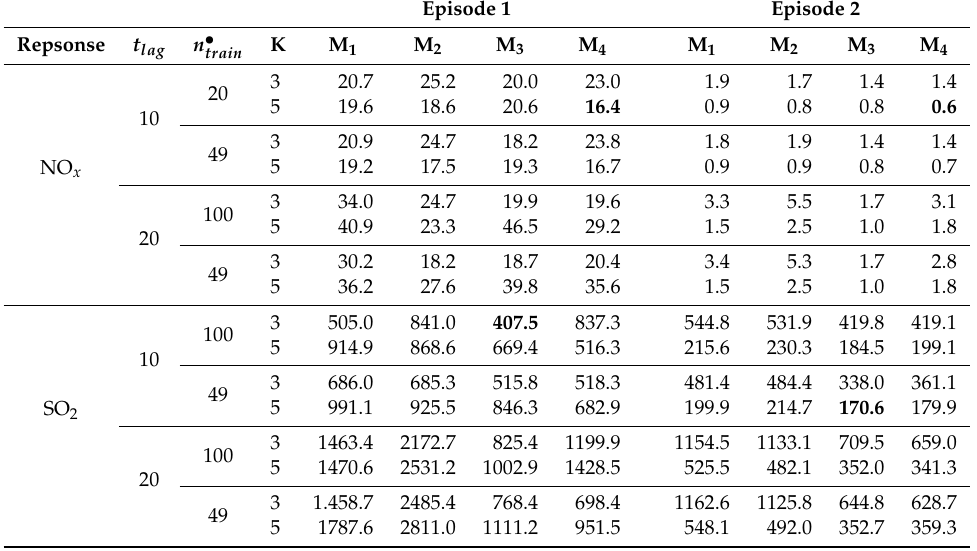
Table 3. RMSE values for two pollution episodes and the four models tested, considering curves with two different time lags, size of the training samples and number of principal components.